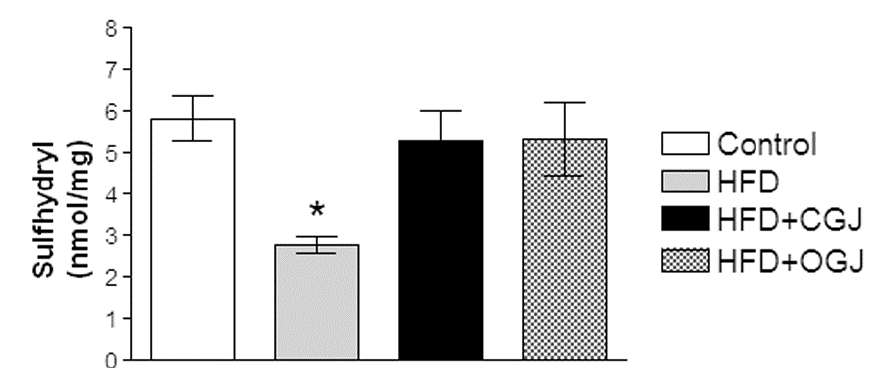
Figure 2. The effect of purple grape juices and high-fat diet on protein sulfhydryl groups in the liver of rats. Values are the means ± SD for 8–10 samples in each group expressed as nmoL/mg. Statistically significant differences were determined by ANOVA followed by the Tukey test: * p < 0.05, different from the other groups. HFD, high-fat diet; CGJ, conventional grape juice; OGJ, organic grape